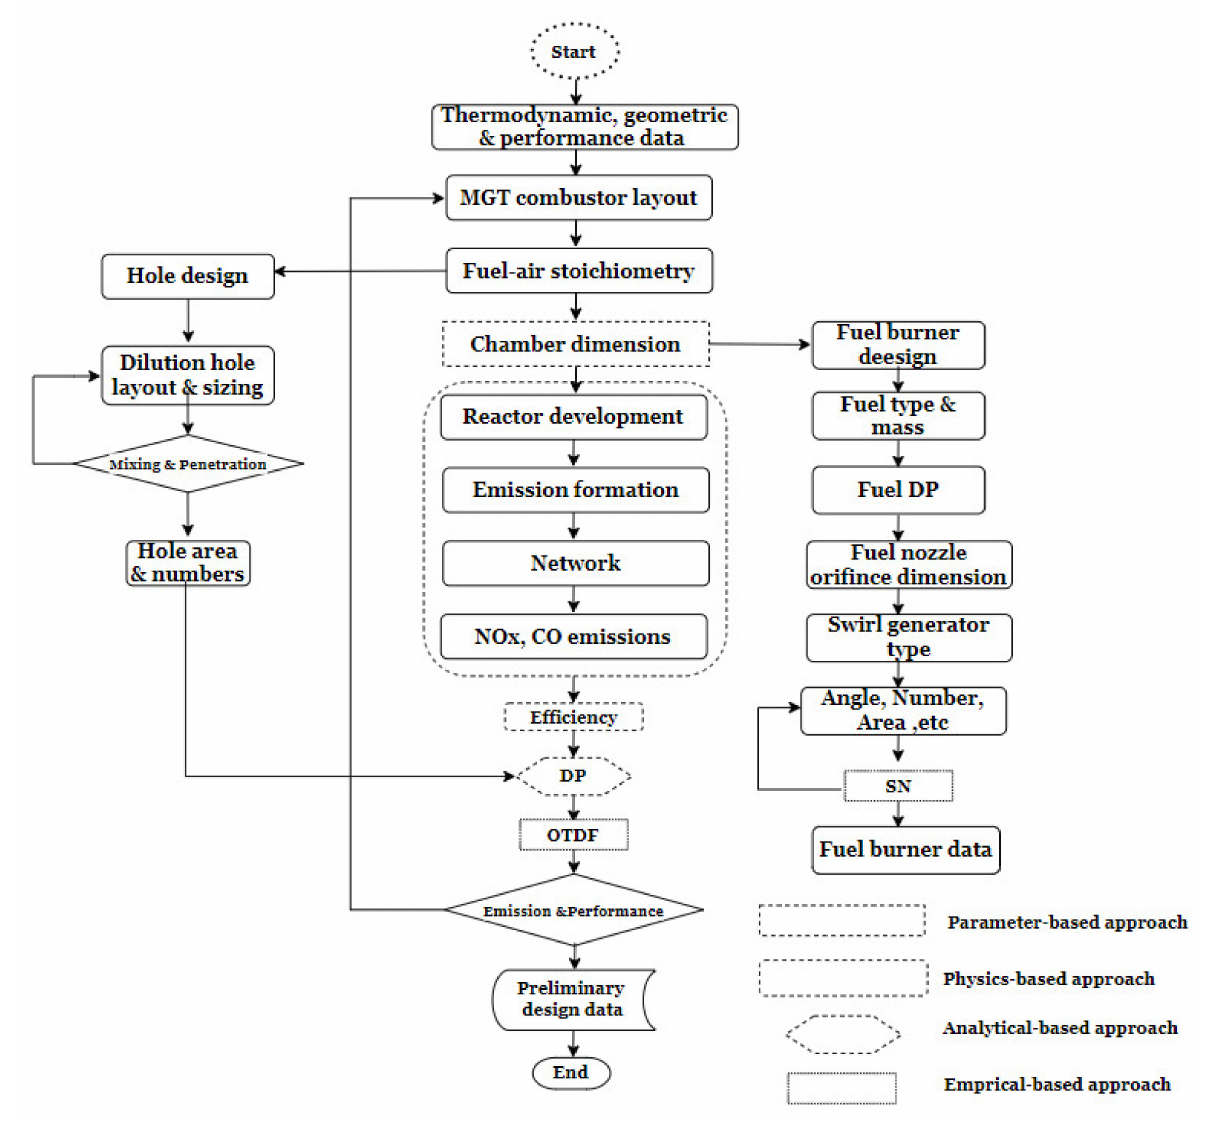
Figure 2. Preliminary design procedure. Table 1. Main design